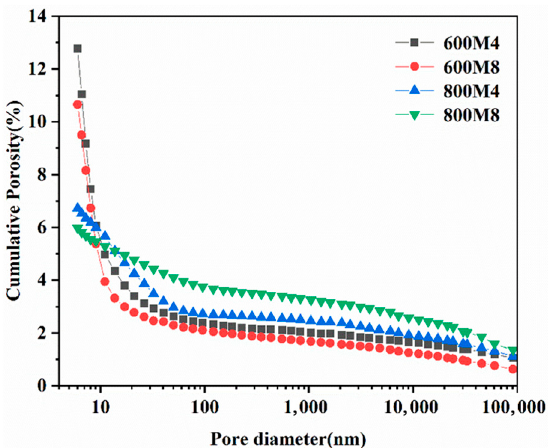
Figure 13. Cumulative porosities of MOC with magnesium residue calcined at different temperatures and Baume after hydration for 28 d. (In 800M4, 800 represents the calcination temperature of 800 °C, M4 represents the Baume degree of magnesium chloride is 24, and the M8d love table represents the Baume degree of magnesium chloride is 28). Table 5. The phase and their quantities in MOC with different Baume and different calcination temperature of magnesium residue for 28 d.